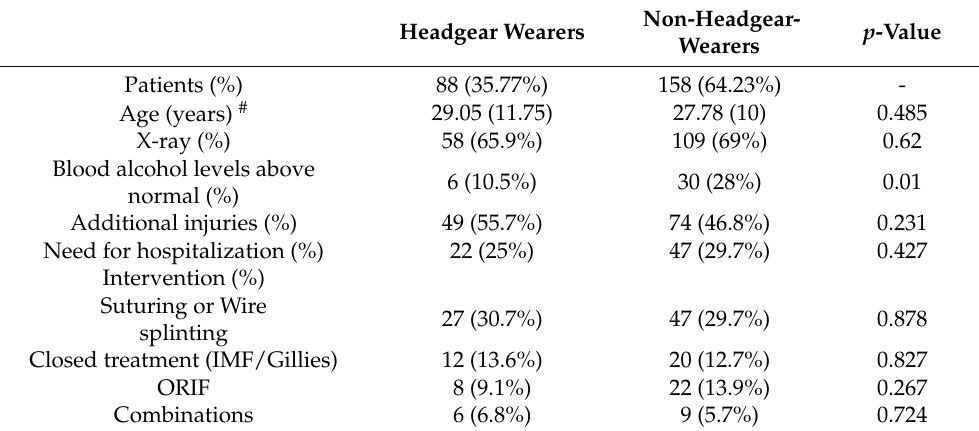
Table 2. Differences between headgear-wearers and non-headgear-wearers (n = 246